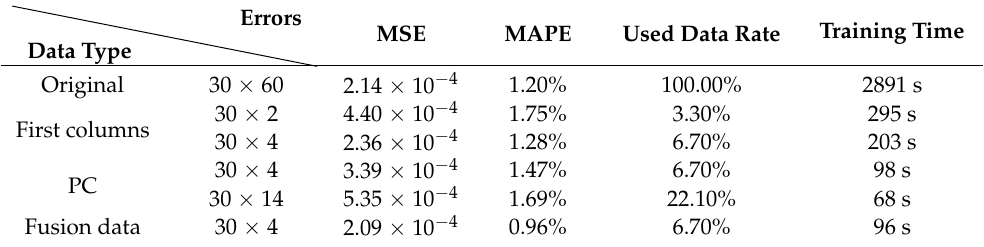
Table 4. Error evaluation